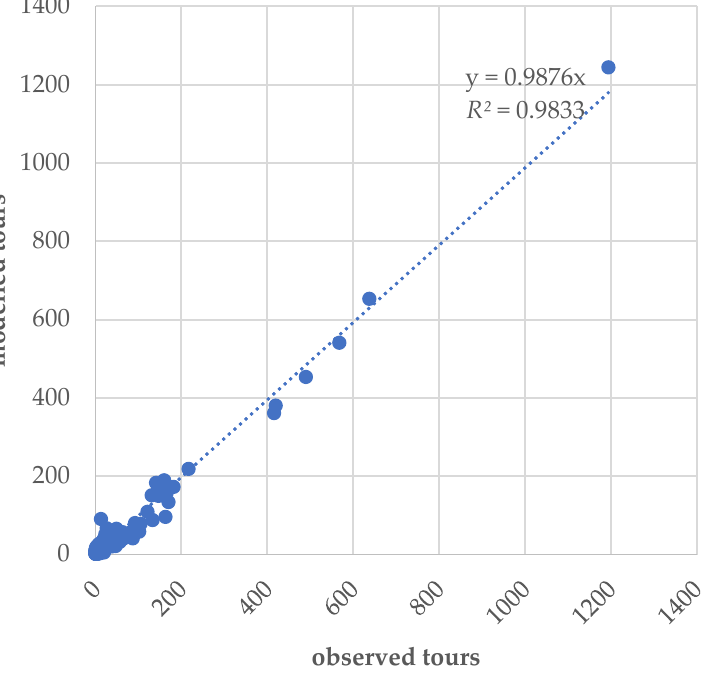
Table 1. Calibrated parameters.